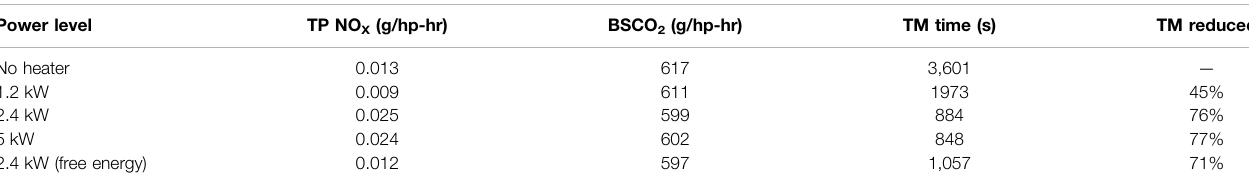
TABLE 9 | LLC time in engine thermal management. Power